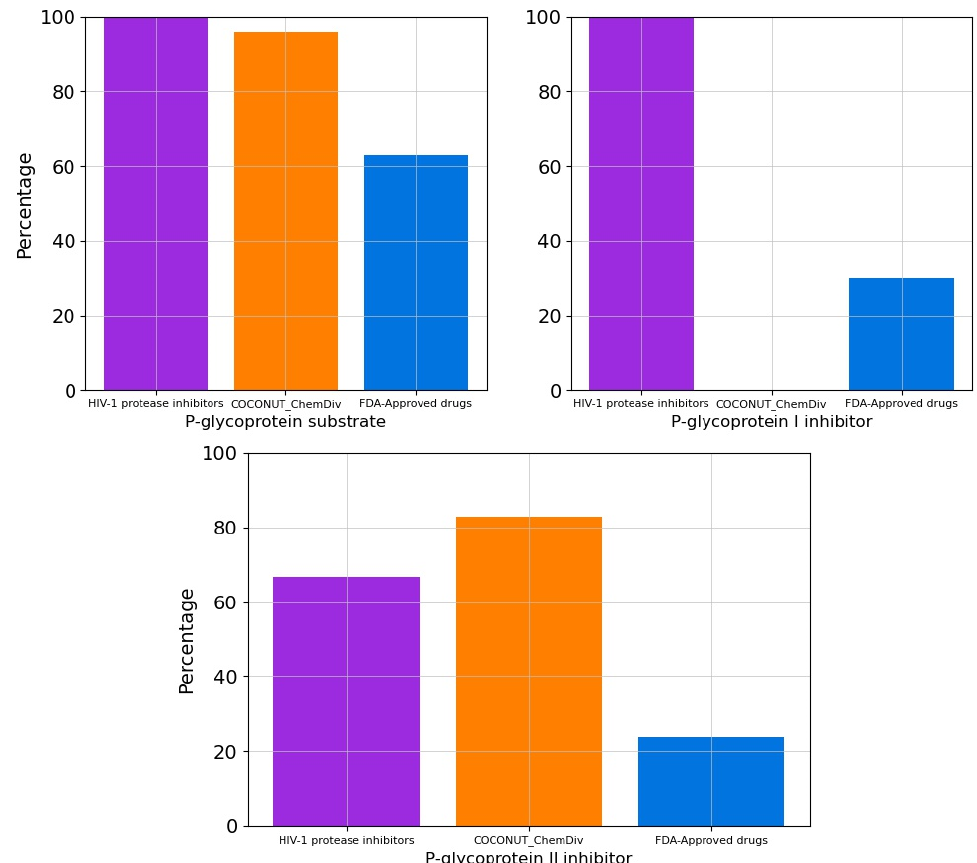
Figure 12. Percentage of compounds that are P-glycoprotein substrate, P-glycoprotein I inhibitor, and P-glycoprotein II inhibitor. Colors represent compounds: new chemical compounds generated from COCONUT fragments and ChemDiv fragments with physicochemical properties like FDA-approved HIV-1 protease inhibitors and easily synthetically accessible (orange), FDA-approved drugs (blue), FDA-approved HIV-1 protease inhibitors (purple).